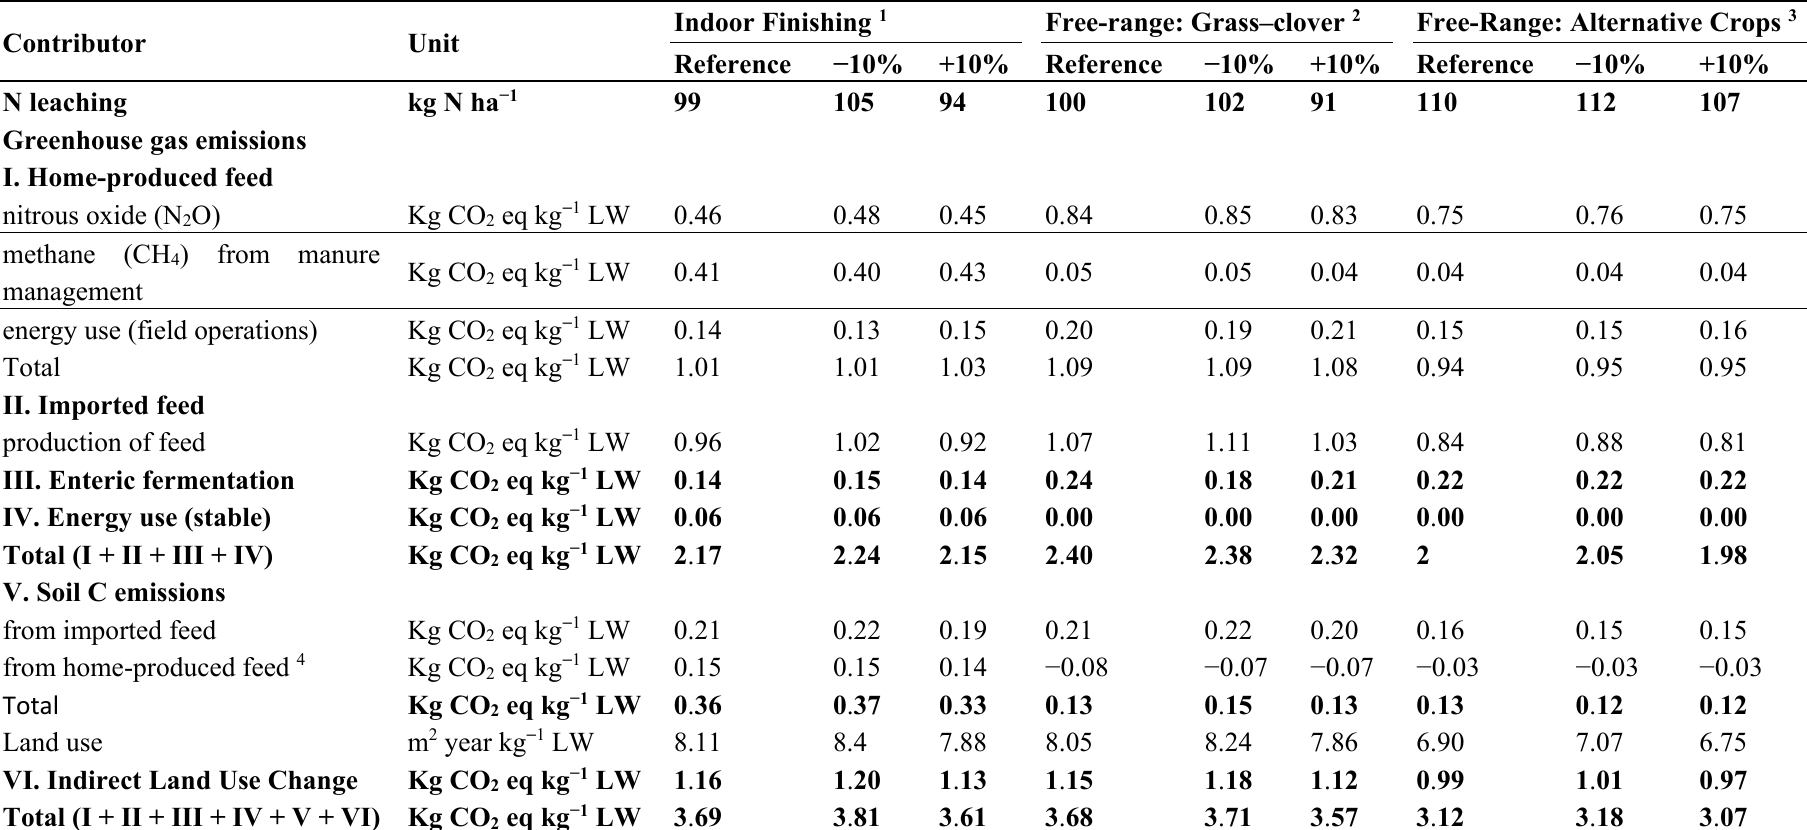
Table 8. Sensitivity analysis of three organic pig production systems presented in kg N ha −1 and kg CO 2 eq. kg LW −1 . The analysis was based on a 10% increase and decrease, respectively, of cereal yields. Reference refers to unchanged cereal